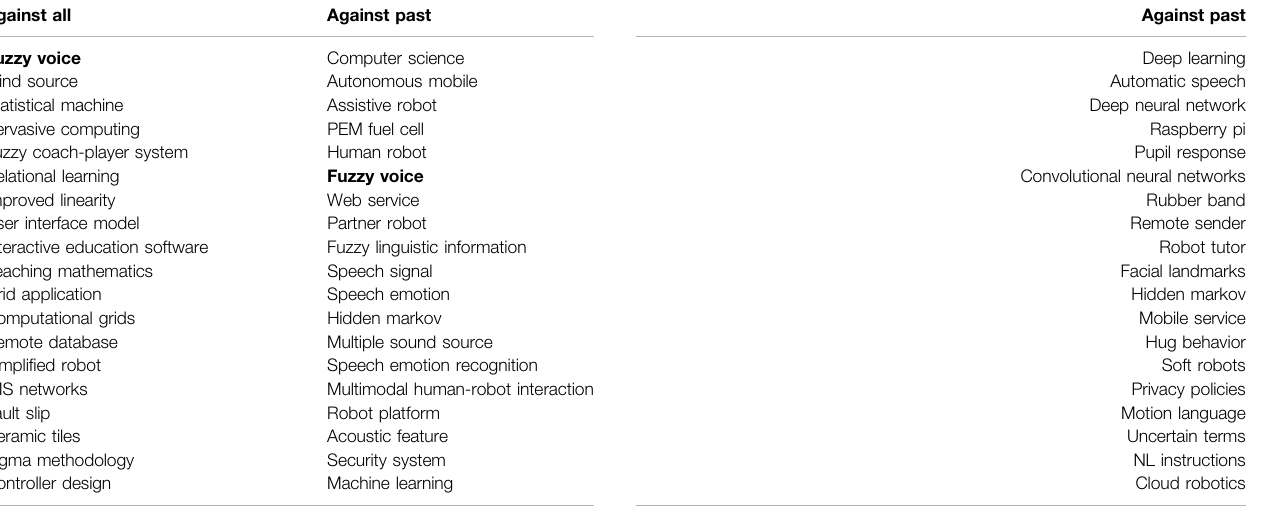
TABLE 4 | Contrastive analysis: range 2015 –